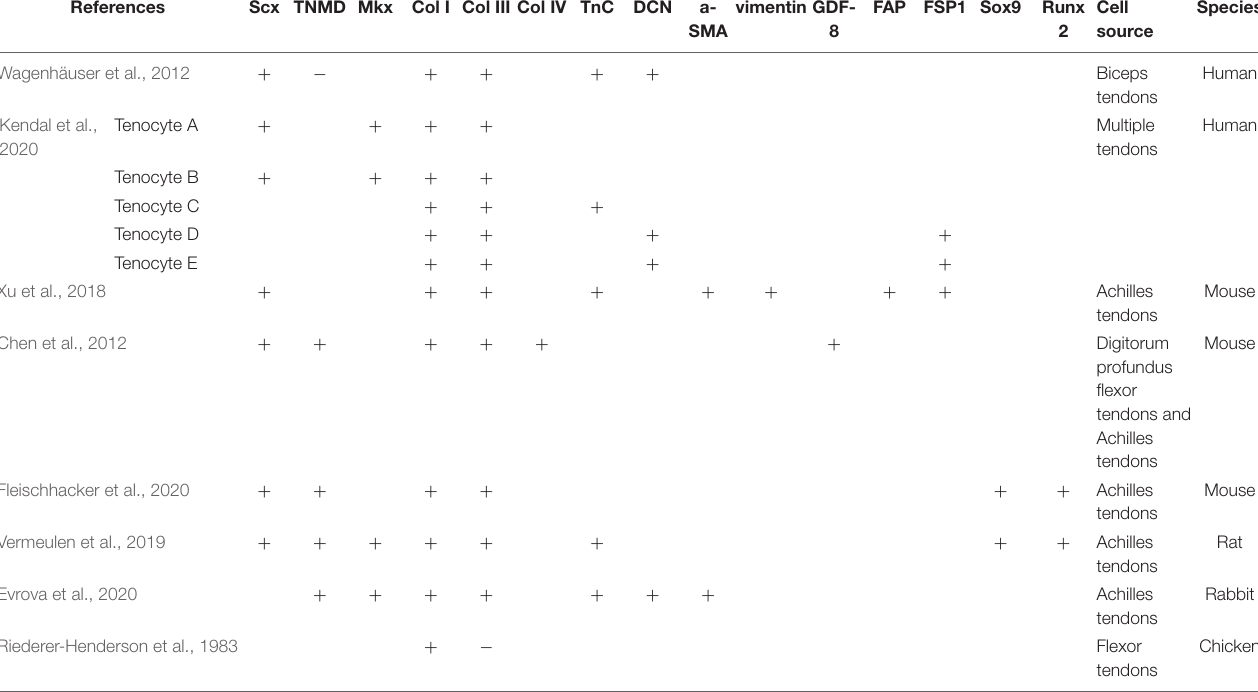
TABLE 1 | Expression of positive and negative markers in tenocytes in different